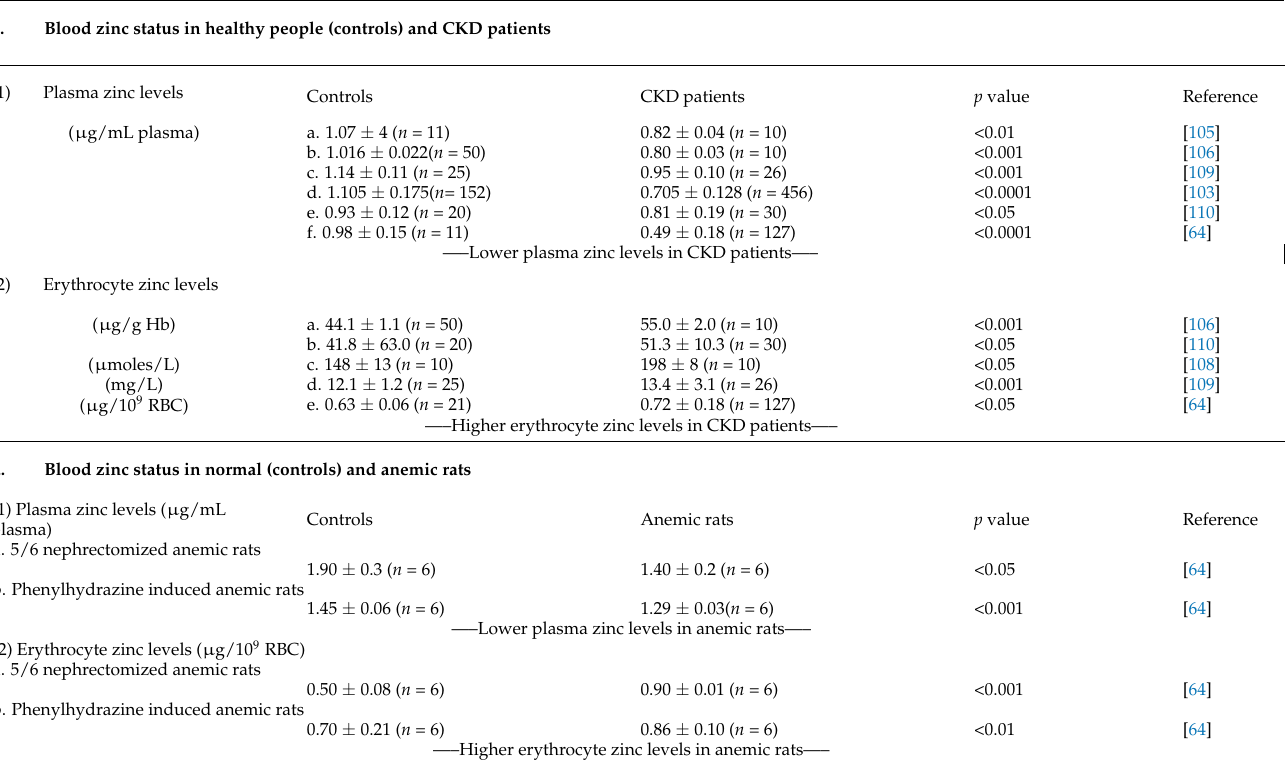
Table 3. Anemia leads to abnormal blood zinc levels in